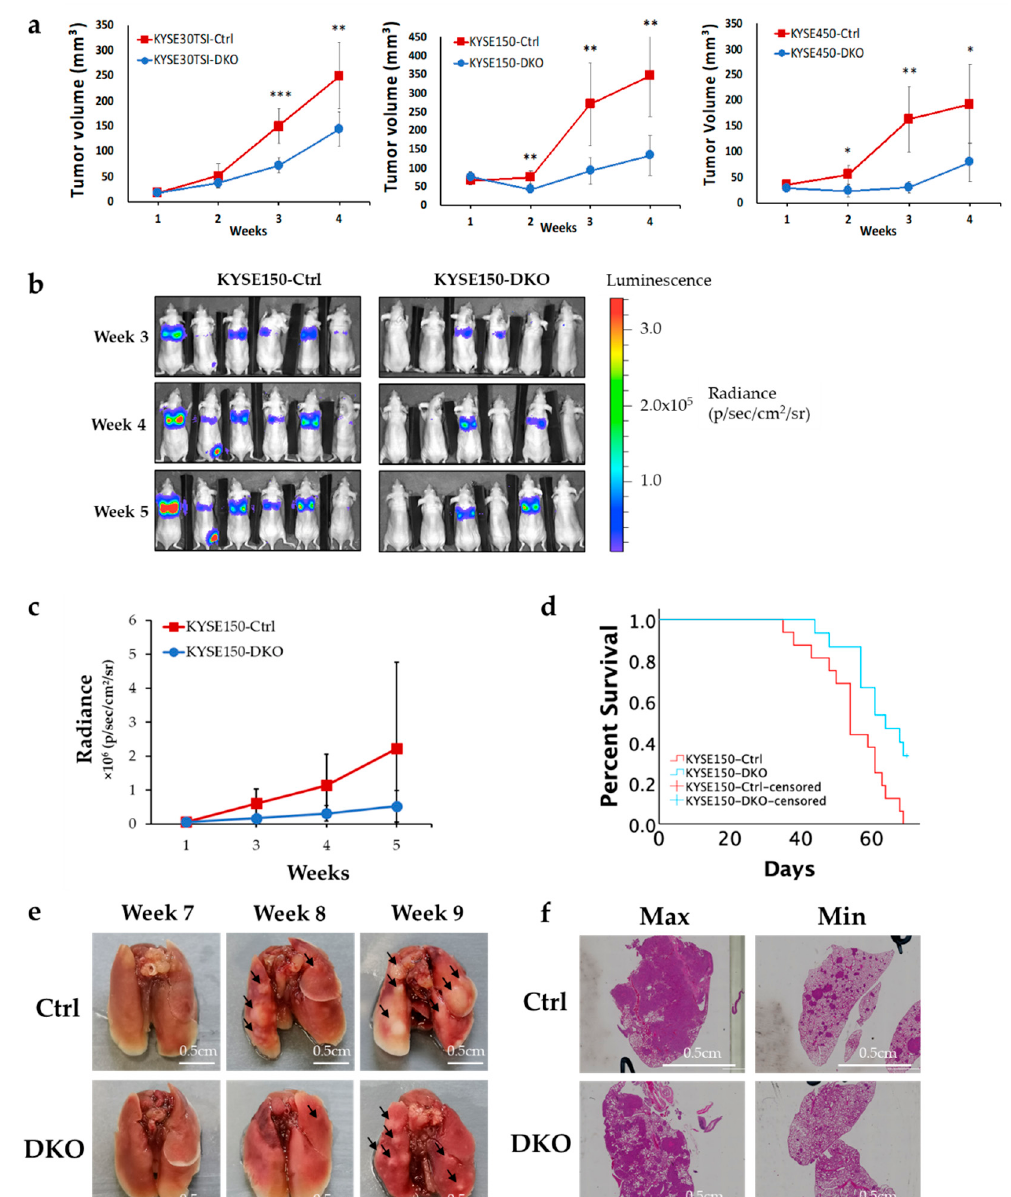
Figure 2. FANCD2 expression regulates in vivo tumor growth and metastasis. ( a ) Subcutaneous tumor growth is suppressed in FANCD2-KO ESCC cells. The data are shown as the mean ± 95% confidence interval ( n = 12). ( b ) Representative images showing weaker and fewer bioluminescence signals in FANCD2-KO mice by live animal imaging. ( c ) Metastasis tumor volume was assessed at 3, 4 and 5 weeks after tail-vein injection. Using ROI analysis, tumor light intensity was calculated, which corresponds with the number of live cells in vivo. Lower bioluminescence signal was measured in FANCD2-KO mice compared with control mice. The data are shown as the mean ± 95% confidence interval ( n = 16). ( d ) FANCD2-KO significantly increases the overall survival rate (Log Rank p = 0.007). ( e ) Representative lung images showing less and smaller tumor masses (arrow) in FANCD2-KO mice compared to the controls. ( f ) Representative lung sections showing fewer and smaller metastatic foci in FANCD2-KO mice under microscopy. Ctrl, control; DKO, FANCD2 knockout; * p < 0.05; ** p < 0.01; *** p < 0.005.